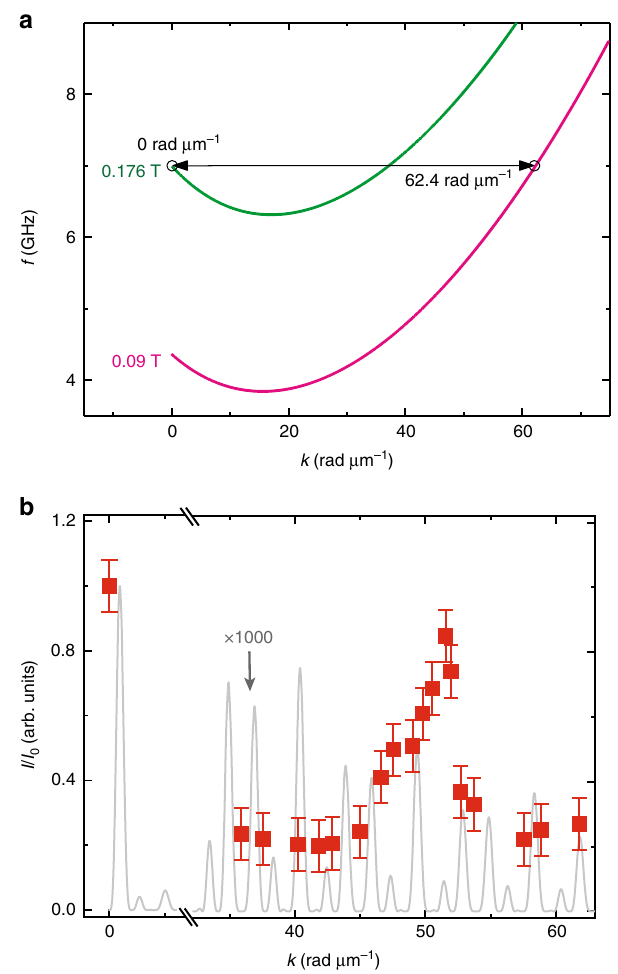
Fig. 6 Wavelength conversion and magnon signal strengths. a Dispersion relations of magnons which are calculated using the formalism of Kalinikos and Slavin 38 in the gap region R G of an mCPW (green) and in the region R ext of bare YIG (pink) considering sample 1. b Normalized signal strength I ∕ I 0 of magnon resonances (squares) extracted from data such as those shown in Fig. 2d at 0.09 T. I ( I 0 ) is the peak-to-peak signal strength in Δ S 21 at k ( k 1 of a CPW). Error bars represent the noise level observed in the spectra. The solid gray line re fl ects the Fourier transformation (power spectrum) of the in-plane radio-frequency fi eld component of h rf of a nonmagnetic CPW. Source data are provided as a Source Data fi